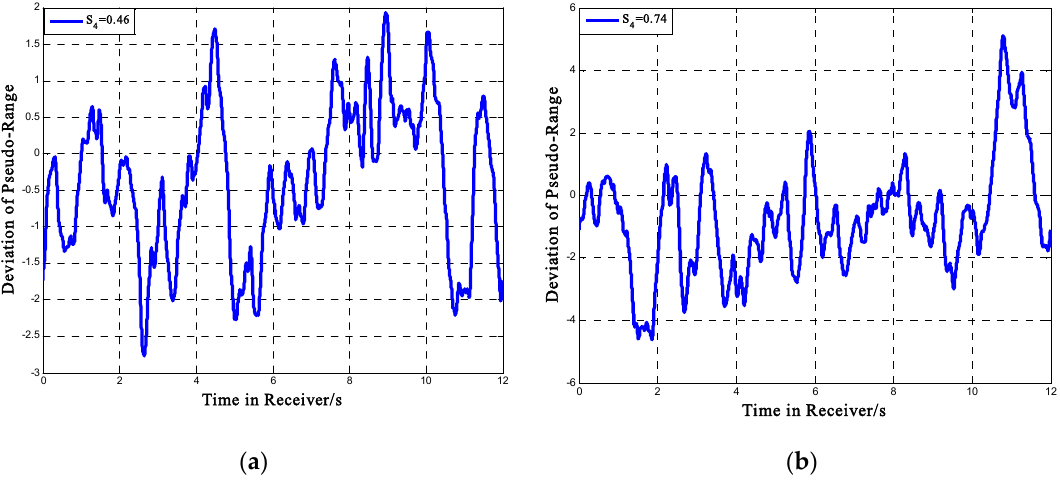
Figure 13. Deviation of Pseudo-Range ( a ) S 4 = 0.46; ( b ) S 4 = 0.7.